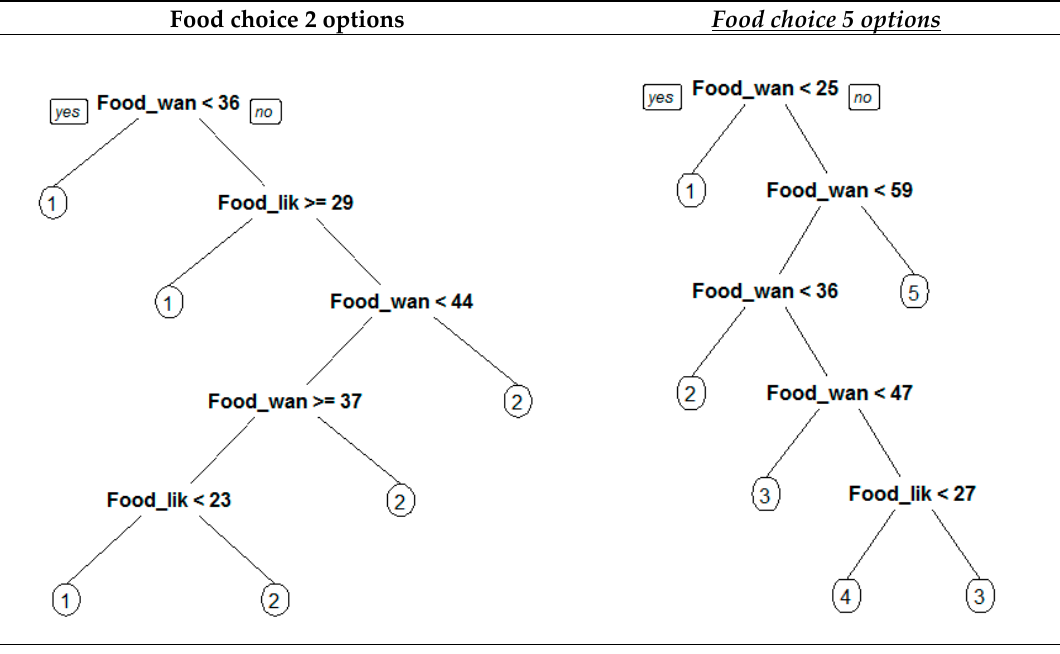
Figure 9. Classification tree food choice—2 and 5 options.